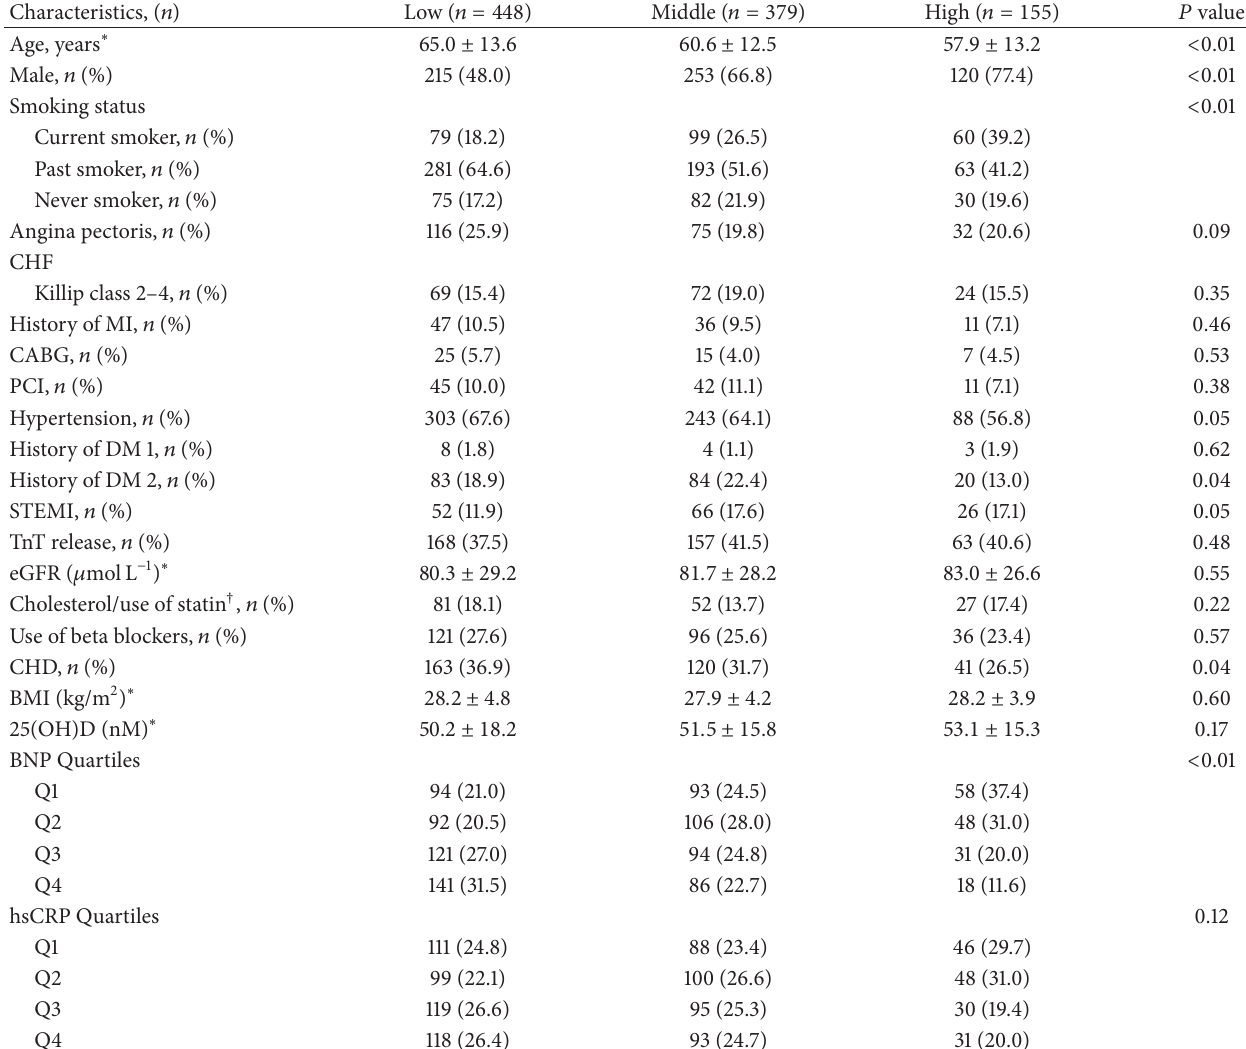
Table 2: Baseline characteristics of the total population according to socioeconomic